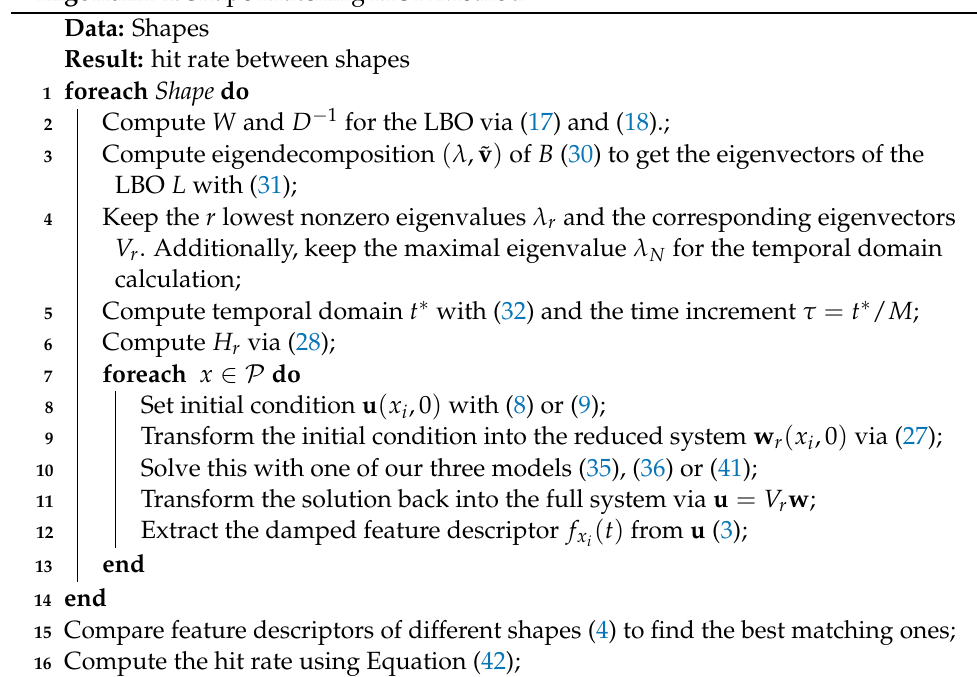
Algorithm 1: Shape Matching MOR